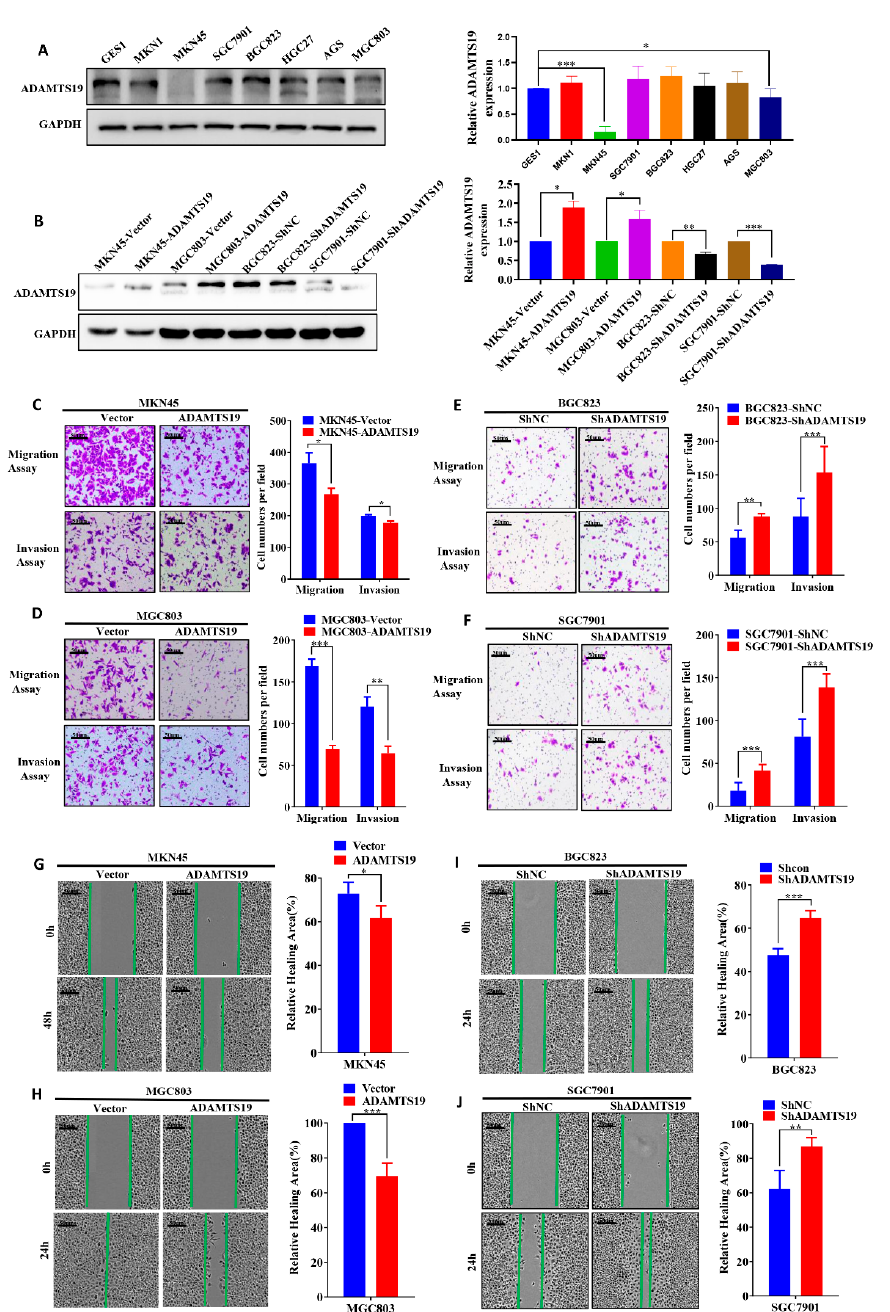
Figure 2. ADAMTS19 suppresses GC cell migration and invasion in vitro. ( A ) ADAMTS19 protein expression levels measured in seven gastric cancer cell lines (MKN1, MKN45, SGC7901, AGS, BGC823, HGC27, and MGC803) and one normal gastric epithelial cell line (GES1) by Western blotting. ( B ) MGC803 and MKN45 cells with low expression of endogenous ADAMTS19 were chosen to construct stably-overexpressed ADAMTS19 cells transfected with a lentiviral vector, and BGC823 and SGC7901 cell lines with high endogenous ADAMTS19 were stably transfected with shRNA through a lentiviral vector. ADAMTS19 expression in stably transfected cells was confirmed by Western blotting. ( C – F ) Overexpression of ADAMTS19 suppressed GC cell migration and invasion, while ADAMTS19 knockdown reversed the effects. ( G – J ) Wound healing assays showed that overexpression of ADAMTS19 significantly inhibited wound healing in MKN45 and MGC803, whereas ADAMTS19 knockdown promoted wound healing in BGC823 and SGC7901. The data are presented as means ± standard deviations. * p < 0.05; ** p < 0.01; *** p <